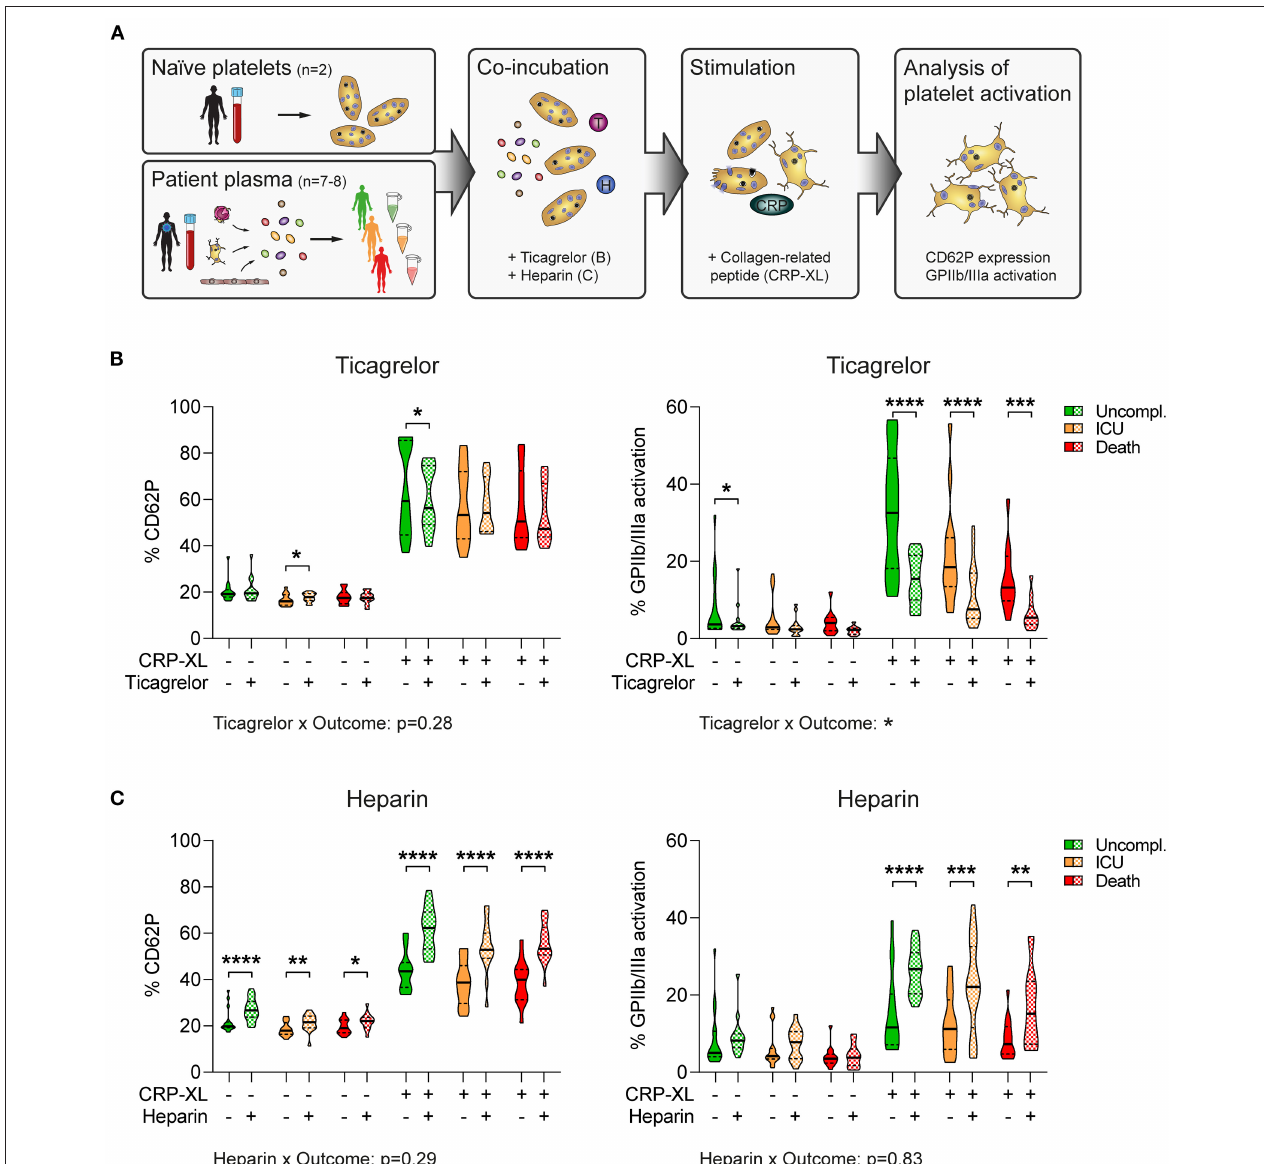
FIGURE 5 | Plasma-mediated reduced platelet GPIIb/IIIa activation is disproportionately exacerbated by antiplatelet therapy in fatal COVID-19. (A) Experimental setup: Naïve platelets of healthy donors were incubated with plasma of patients with COVID-19 with different outcomes in the presence of ticagrelor or heparin, followed by stimulation with CRP-XL and evaluation of platelet activation via flow cytometry. (B,C) Naïve platelets were incubated in patient plasma in the presence of DMSO (solid), (B) 2.5 µ M ticagrelor, or (C) 2.5 U/ml heparin (both checkered) for 10min before stimulation with CRP-XL (50ng/ml, 15min) and measurement of CD62P expression (left panel) and GPIIb/IIIa activation (right panel). Differences between DMSO control and ticagrelor/heparin were tested by two-way ANOVA. Outcome-specific effects of ticagrelor or heparin were evaluated 3-way ANOVA. n = 2 platelet donors/7–8 patient plasmas per outcome. * p < 0.05, ** p < 0.01, *** p < 0.001, **** p <